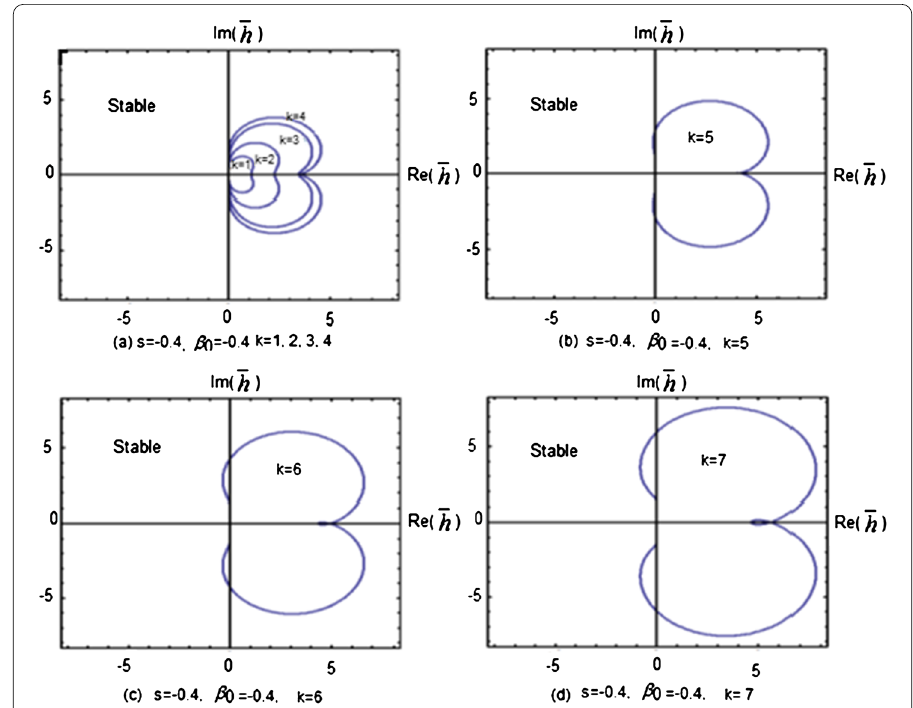
Figure 1 The absolute stability domain of class (3–4) for k = 1 up to